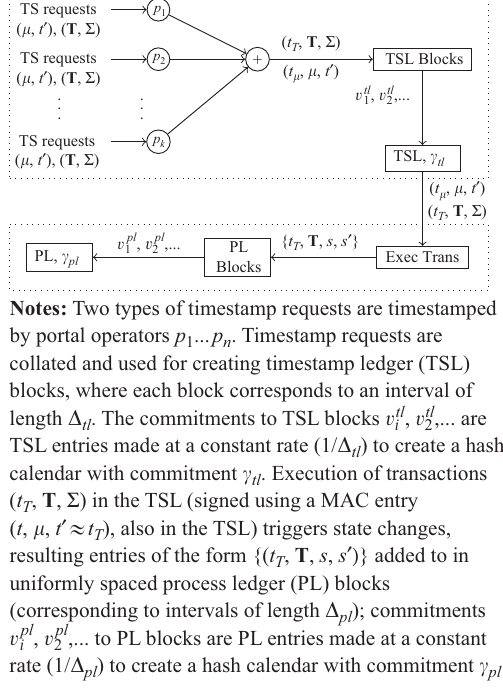
Figure 2. A scalable blockchain for executing large-scale